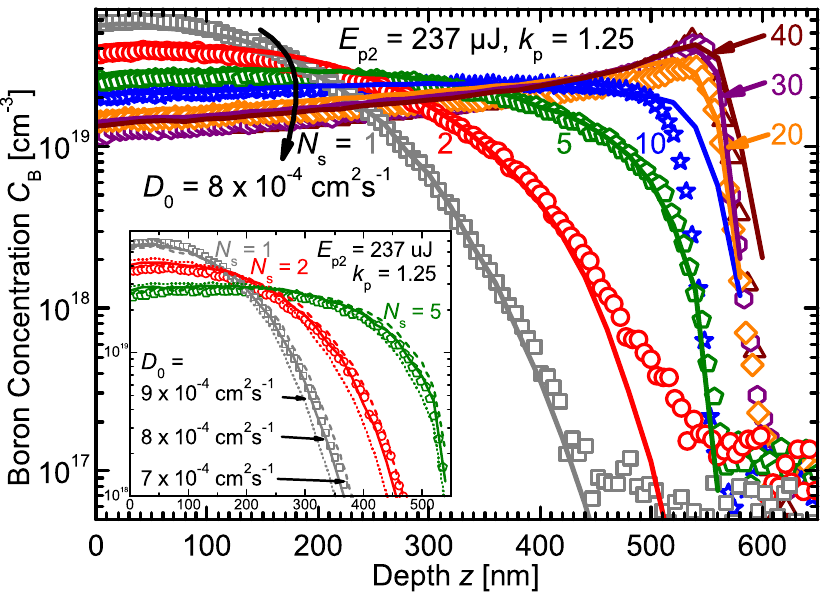
Figure 2. SIMS boron profiles (data points) of silicon wafers irradiated with varied number of laser scans N s for constant laser pulse energy E p 2 = 237 µ J. Numerical simulations (lines) with a diffusivity D B = 8 × 10 − 4 cm 2 · s − 1 × exp [ − E a / ( k B T )] and partitioning coefficient k p = 1.25 yield the best fits to the SIMS data. The inset shows the influence of varied diffusivity on the shape of the simulated profiles for small number of laser scan